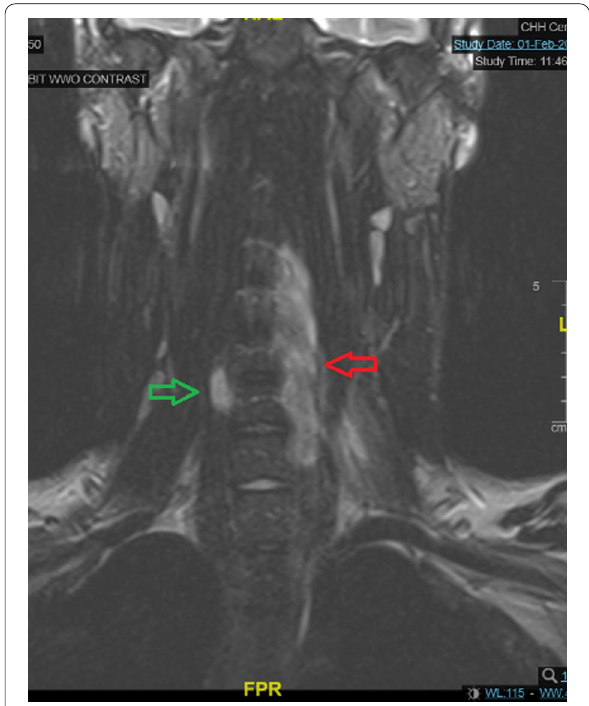
Fig. 1 MRI neck soft tissues with contrast, showing increased signal intensity in the left longus colli muscle from C4 to C7 (red arrow) and in the right longus colli muscle from T6 to T7 (green